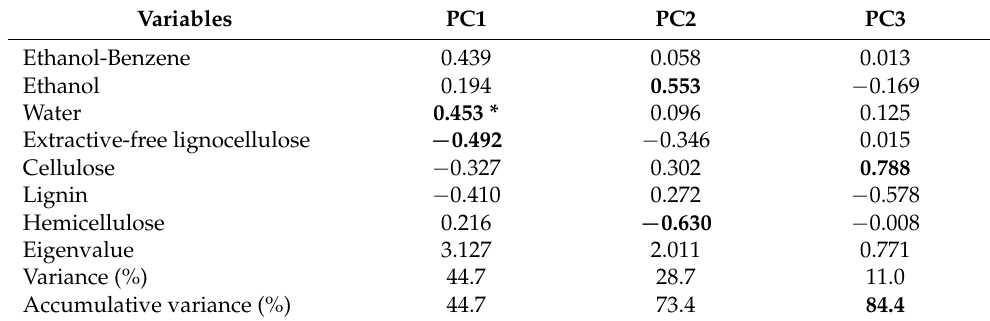
Table 5. Vectors, eigenvalues, and cumulative proportion of the variation are explained by each variable.